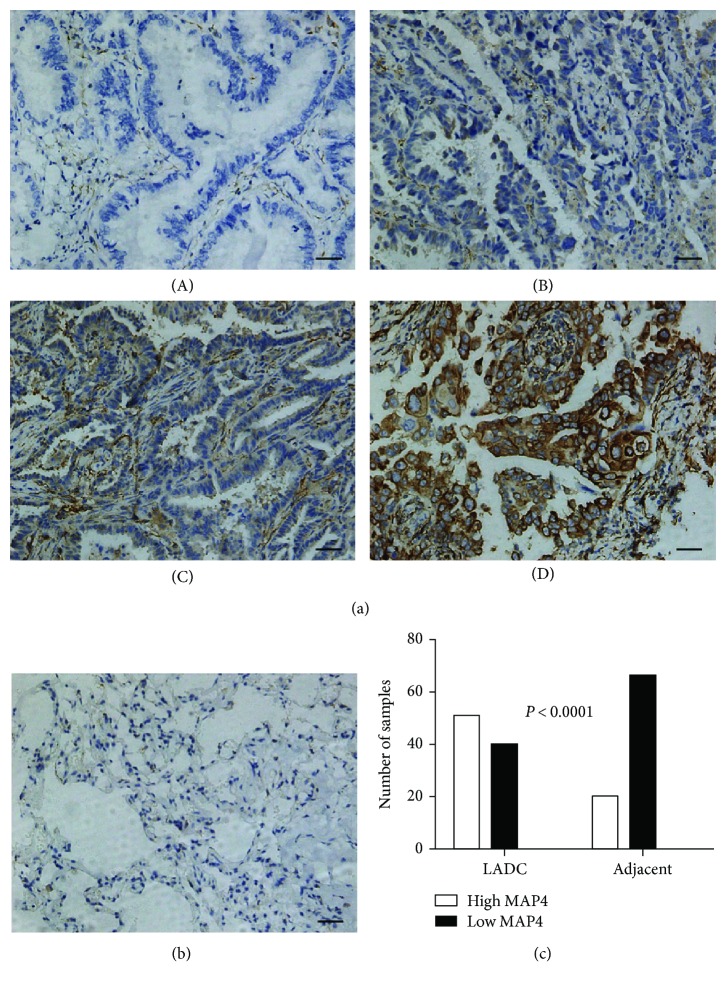
MAP4 expression in LADC tissues and adjacent normal lung tissues (bar = 100 μm, 200x). (a) Immunohistochemical analysis of MAP4 in tumor tissue samples: (A) negative expression; (B) low expression; (C) moderate expression; (D) high expression. (b) Negative MAP4 expression in adjacent tissues. (c) MAP4 expression was examined by IHC in 91 LADC tissue samples and 86 matched adjacent normal lung tissue samples. MAP4 expression was significantly increased in tumor tissues compared with that in adjacent lung tissues (P < 0.0001, paired samples t-test).